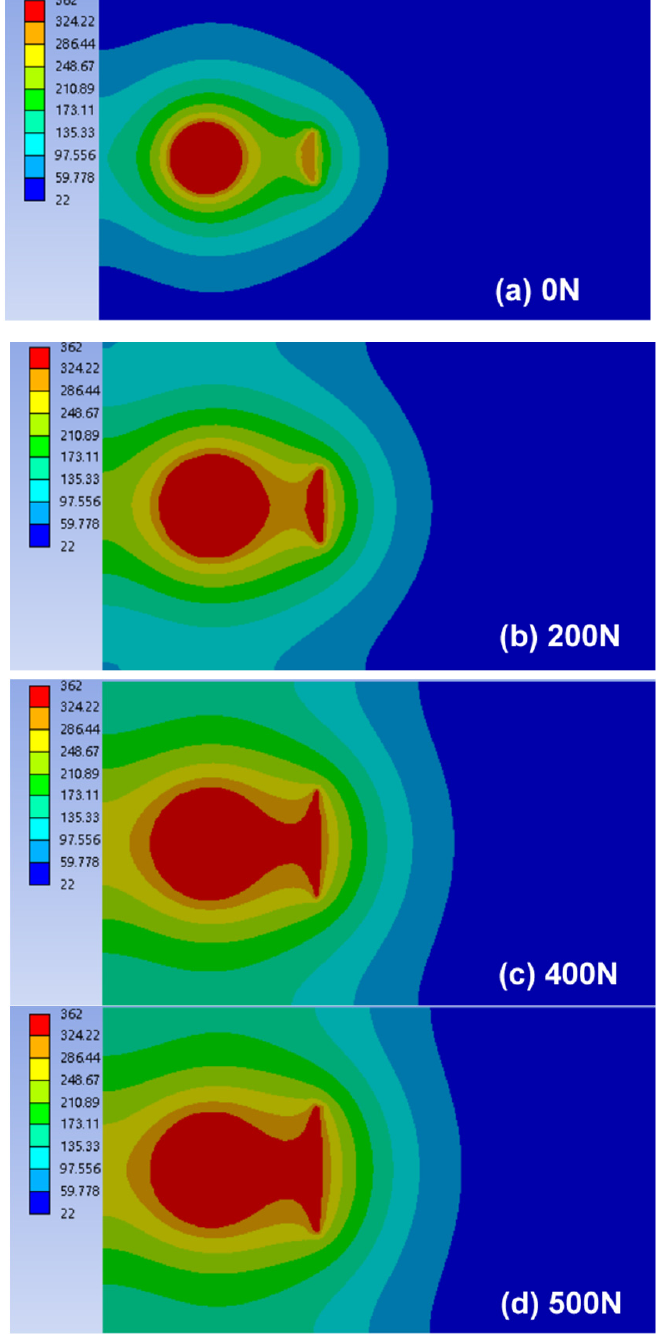
Figure 15. Simulation results of the temperature distribution for joint with 1.5 mm gap between workpieces under various preloads (Units in °C).